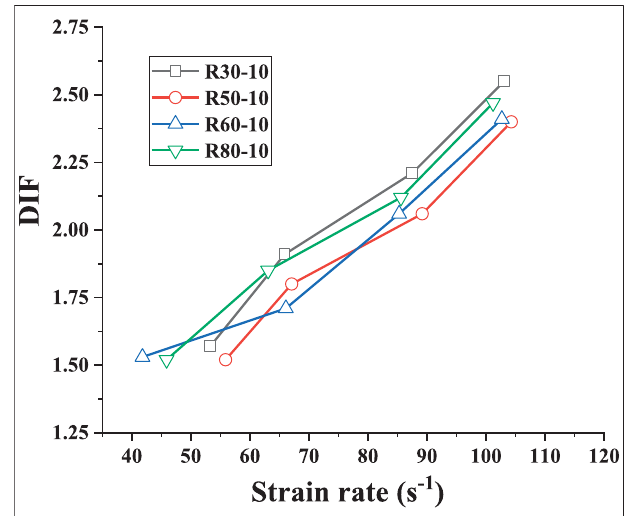
FIGURE 14 | The relationship between (Dynamic Increase Factor) DIF and strain rate.